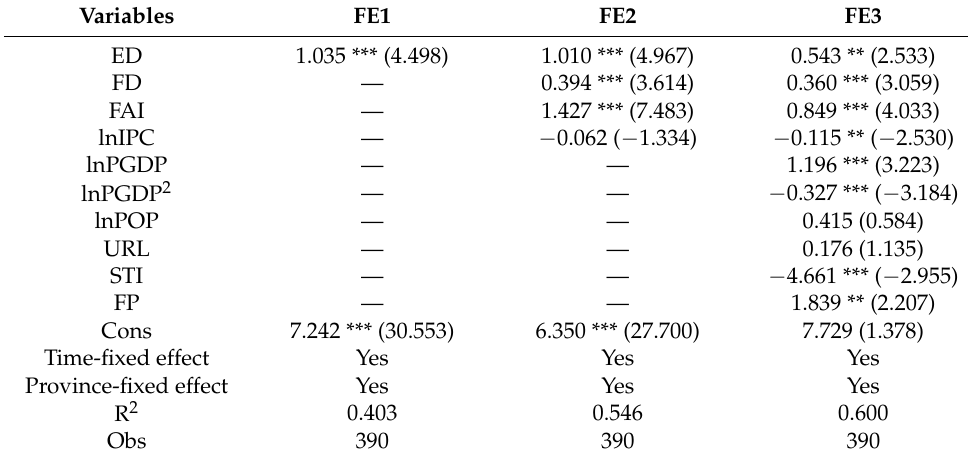
Table 3. Basic estimation